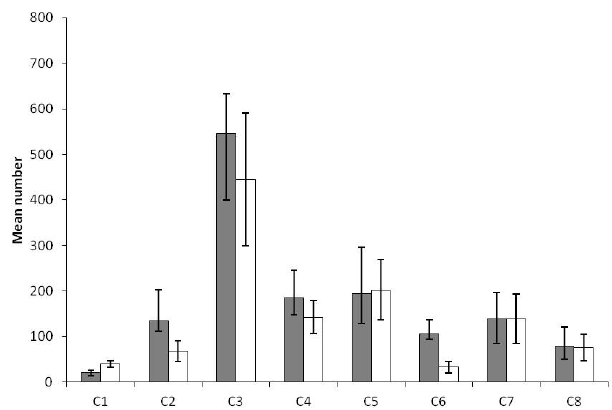
Fig 3 . Mean number and standard deviation of the frequency of behaviors executed by Atta sexdens rubropilosa workers during culture of the symbiotic fungus on bait pellets (gray bars) and leaf disks (white bars). C1: Transporting the disk/pellet to the surface of the fungus garden; C2: holding the disk/pellet; C3: licking the surface and borders of the disk/pellet; C4: cutting the leaf disk into smaller fragments/pellet fragmentation; C5: pleating the borders/ pressing the pellet fragment; C6: deposition of fecal fluid; C7: in - corporation into the fungus garden; C8: deposition of hyphae on the incorporated